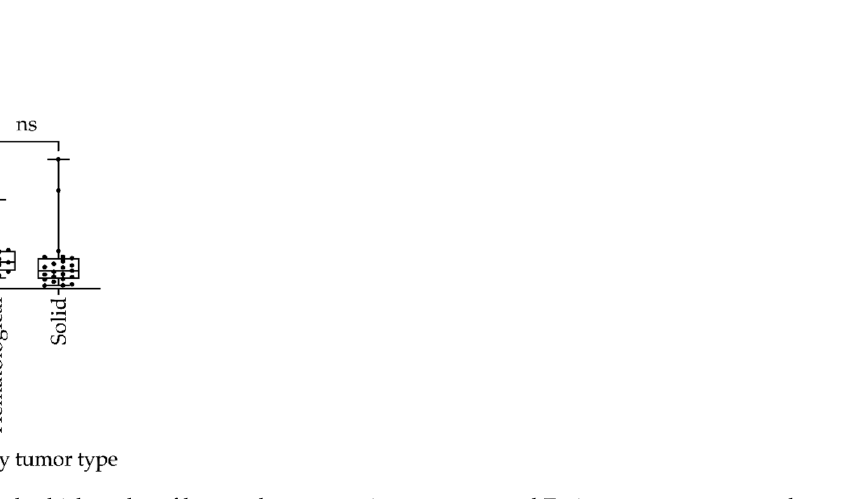
Figure 2. Box-and-whisker plot of latency between primary tumor and Ewing sarcoma as secondary malignant neoplasms (EwS as SMN) compared between hematologic and solid primary tumors in the EICESS 92, Euro ‐ E.W.I.N.G. 99, and EWING 2008 trials. Statistical analysis by unpaired t test, ns = non ‐ significant ( p = 0.55).